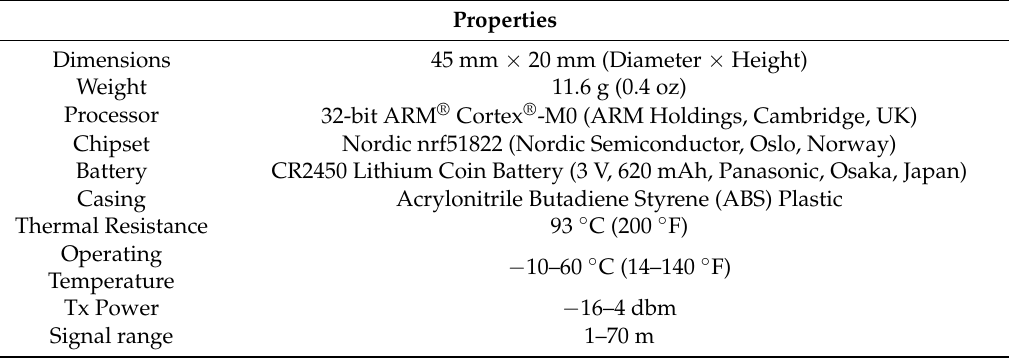
Table 2. Specifications of the RECO beacons (Perples, Seoul, Korea) installed in the underground mine.